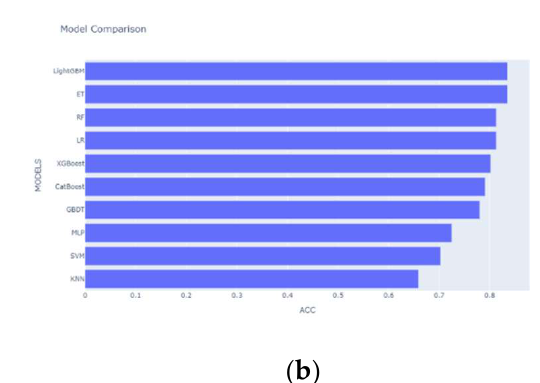
Figure 6. ( a ) Accuracy of SVM, KNN, LR, RF, ET, GBDT, XGBoost, LightGBM, CatBoost and MLP on Heart Dataset. ( b ) Accuracy of SVM, KNN, LR, RF, ET, GBDT, XGBoost, LightGBM, CatBoost and MLP on Heart Attack Dataset.